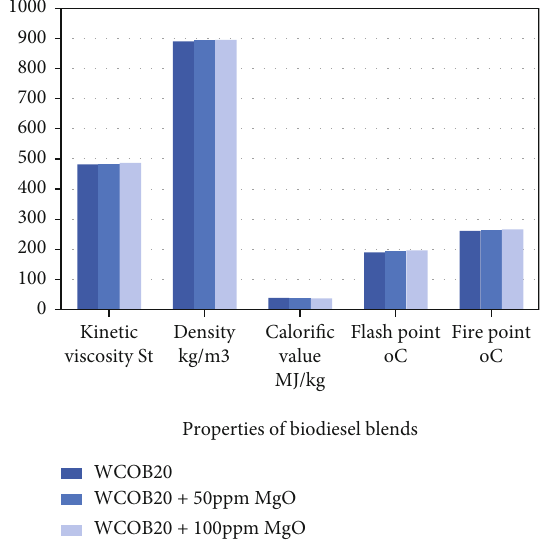
Figure 3: Graphical representation of fuel properties of di ff erent blends.